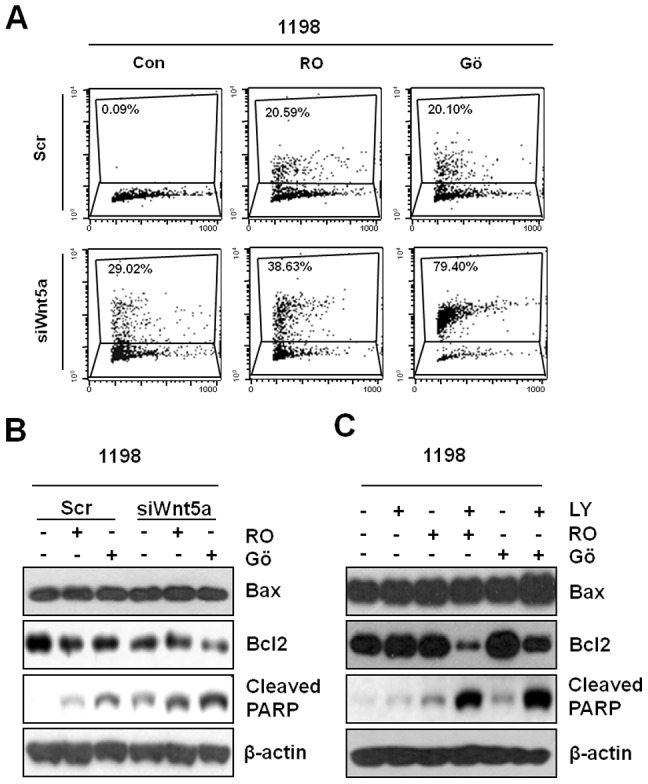
Apoptosis by blocking of siRNA mediated Wnt5a expression and PKC/AKT pathway.(A) 1198 cells were transfected with scrambled siRNA (Scr) or Wnt5a siRNA for 24 h and then treated with PKC inhibitors (RO; 2.5 µM Ro-318226 and Gö; 2.5 µM Gö6o76) ) for 48 h. Apoptosis were determined by the flow cytometric analysis. (B) These cells were analyzed by Western blot analysis of indicated protein expression. (C) 1198 cells were treated with PI3K inhibitor (LY), PKC inhibitors (RO and Gö) or their combination for 72 h and then subjected to Western blot analysis of indicated protein expression. β-actin was used as a loading control.